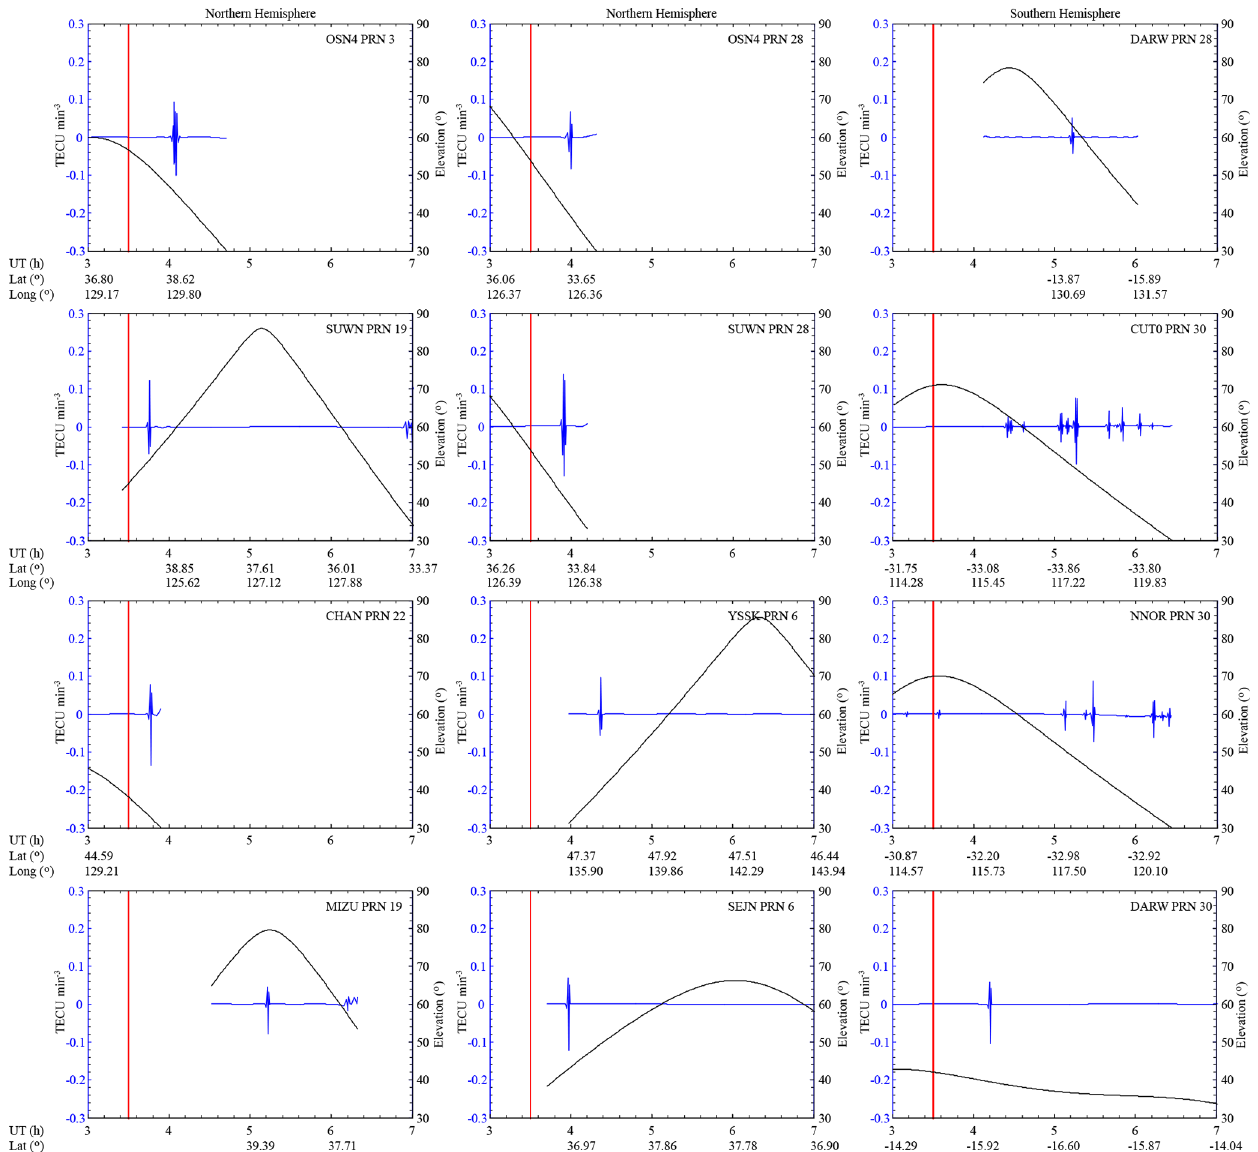
Figure 4. The time sequences of three-order derivatives of carrier-phase-derived relative STEC by GNSS observations from different IGS stations in East Asia (left and middle column) and Australia (right column) on 3 September 2017. The blue lines indicate the wavelet de- noised three-order derivative of relative STEC. The black lines indicate the GPS signal’s elevation between the GNSS satellite and IGS stations. The explosion time is represented by the red